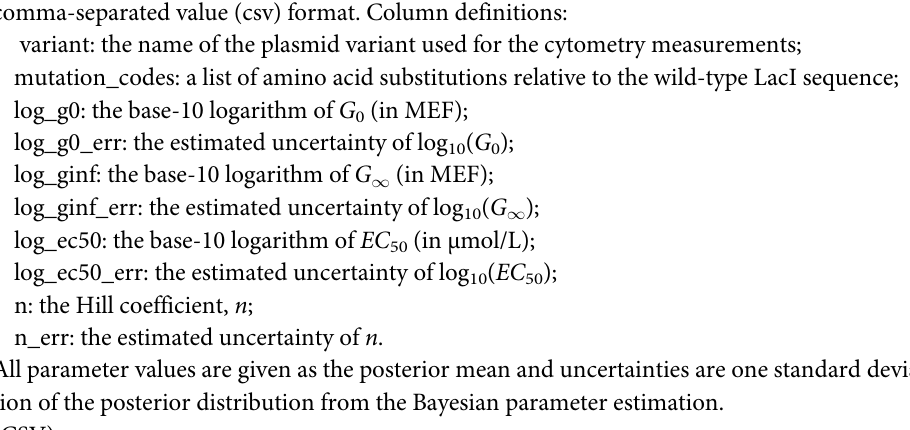
S2 Table. Hill equation fit results (using cytometry data) for all LacI variants. Data is in comma-separated value (csv) format. Column